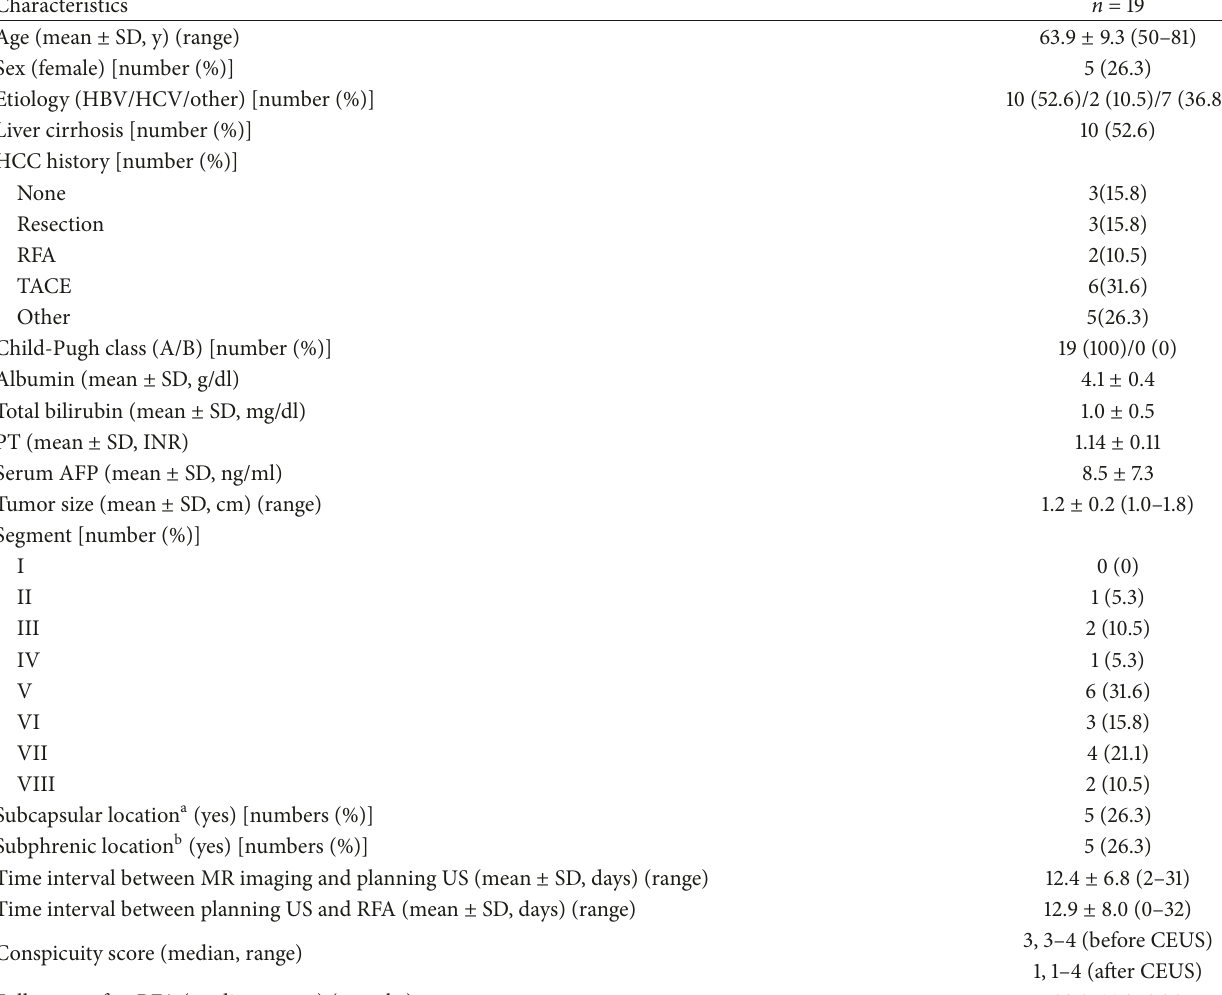
Table 3: Baseline characteristics of 19 patients who underwent percutaneous CEUS-added FI-guided RFA.